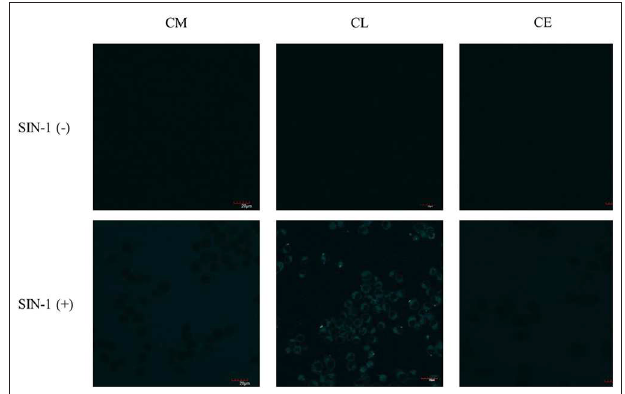
FIGURE 8 | Potential lysosome-targeting CL probe detects SIN-1 generated ONOO − in murine macrophages. RAW 264.7 macrophages were stimulated for 1h with SIN-1 (100 µ M). CM (20 µ M), CL (20 µ M), and CE (20 µ M) were then incubated for 30min, respectively. Blue channel: λ ex = 405nm, λ em